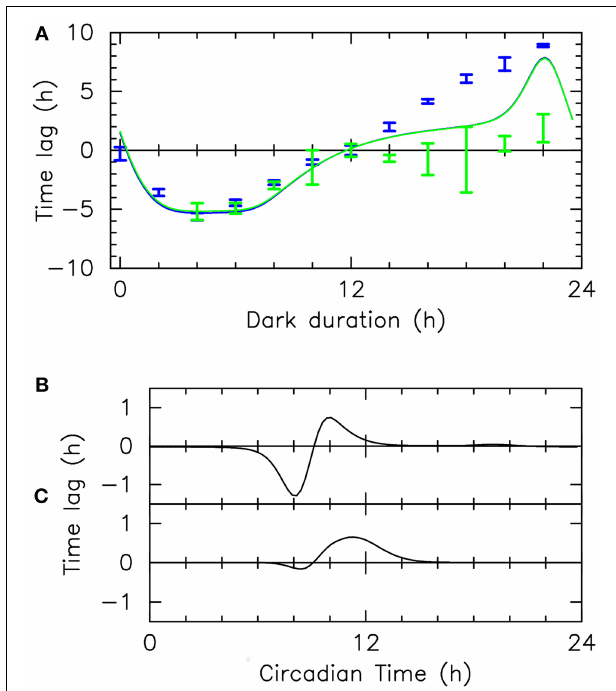
FIGURE 6 | Resetting: numerical simulations and experiments. (A) Phase shifts measured in resetting experiments in blue and green light (blue and green vertical bars, respectively) and corresponding numerical estimates (blue and green solid lines, respectively), as a function of the duration of the last dark period. This phase shift is the difference of the asymptotic phase with that obtained for a 12-h last dark period. Blue (resp., green) light intensity is 10 (resp., 25) μ mol.quanta . m − 2 . s − 1 (B–C) Phase response curves giving the phase shift observed in numerical simulations for an intense 1-h light pulse when only LOV-HK (B) or Rhod-HK (C) is active. These phase response curves characterize the role of the two photoreceptors in resetting the